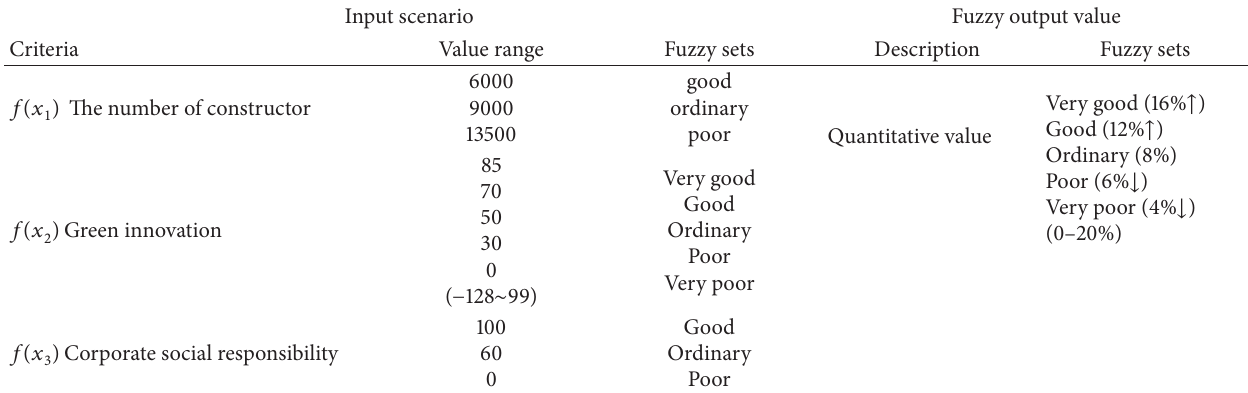
Table 10: Fuzzy set, fuzzy scale and output value.